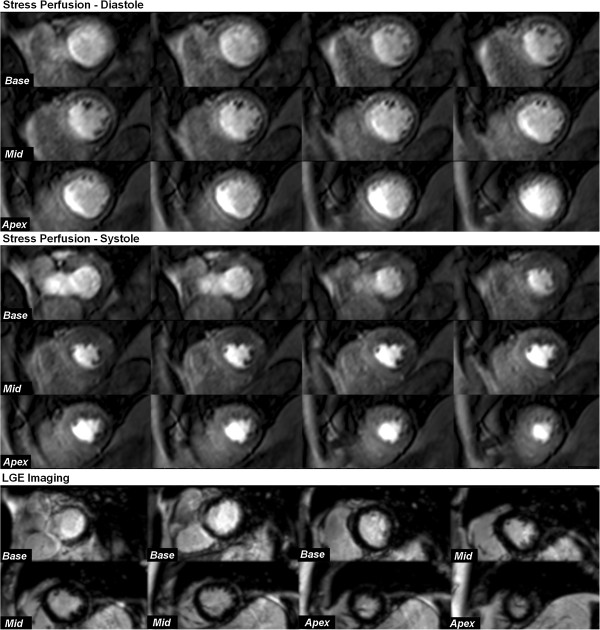
Case example: 3D-perfusion CMR in systole and diastole. This example shows 3D-perfusion CMR in a 75-year-old man with angina. Stress-induced perfusion defects are seen infero-laterally from base to apex and antero-laterally from mid-ventricle to apex in both diastole and systole. However, perfusion defects are difficult to discern from dark-rim artifact in diastole and are more clearly delineated with systolic acquisition. Late-gadolinium enhancement imaging did not reveal any myocardial infarction. X-ray coronary angiography revealed 80% stenosis of a large diagonal branch and significant proximal disease in a large dominant left circumflex artery.